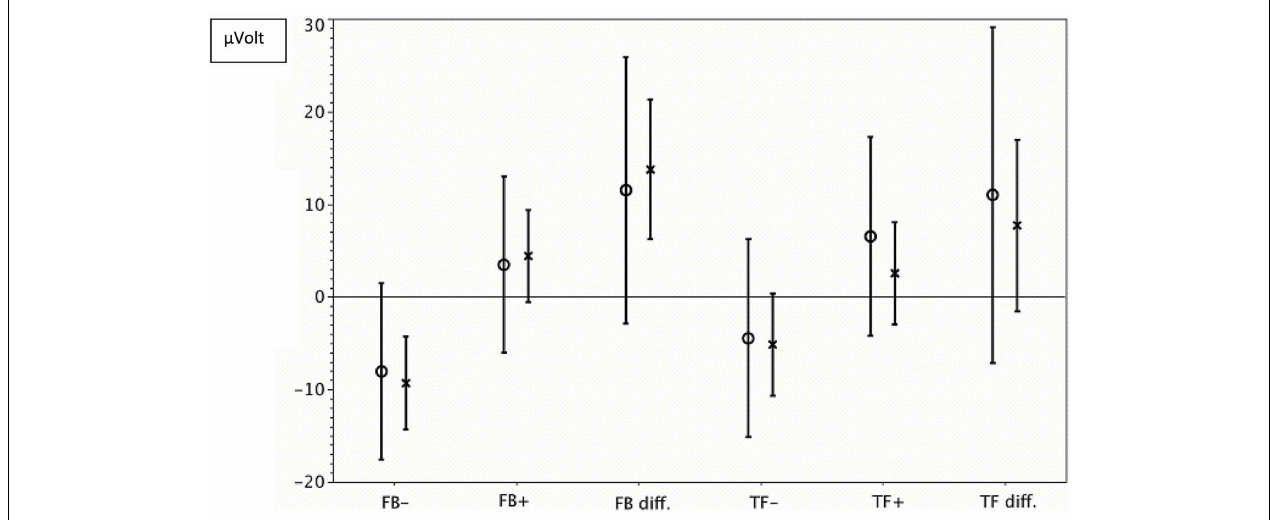
shifts during negativity and positivity tasks with feedback.TF + , positivity tasks without feedback (transfer);TF − , negativity tasks without feedback (transfer);TF diff, difference between shifts during negativity and positivity tasks without feedback